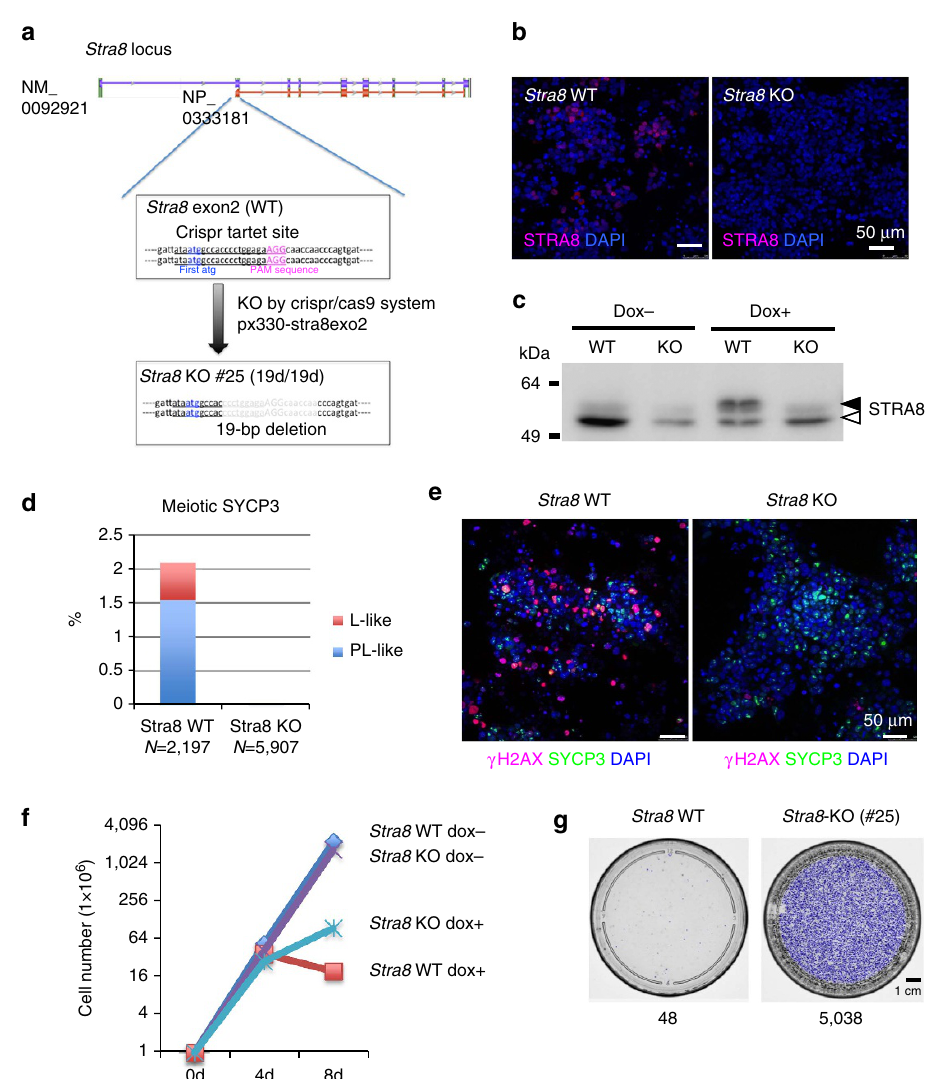
Figure 4 | Induction of the Max expression ablation-mediated meiosis-like SYCP3-staining pattern in ESCs depends on the presence of a functional Stra8 gene. ( a ) Schematic representation of CRISPR-Cas9-mediated disruption of the Stra8 gene. Genomic analyses revealed that Stra8 KO #25 clone had an out-of-frame mutation in both loci of the Stra8 gene due to homozygous deletion of 19 base pairs located immediately downstream of the ATG initiation codon in exon 2 of the gene. ( b ) Confirmation of the absence of functional Stra8 genes in the Stra8 KO #25 Max -null ESC clone. The Stra8 KO #25 clone and parental Max -null ESCs were treated with Dox for 9 days and then subjected to immunocytochemical analyses with an antibody against STRA8. ( c ) Western blot analyses of STRA8 in Stra8 KO #25 clone and parental Max -null ESCs cultured in the presence or absence of Dox. Solid and open arrowheads indicate specific and non-specific bands, respectively. ( d ) Frequency of preleptotene-, leptotene- and zygotene-like staining patterns in the Stra8 KO #25 clone and parental Max -null ESCs treated with Dox for 9 days. ( e ) Immunostaining analyses of g H2AX and SYCP3 in the Dox-treated (9 days) Stra8 KO #25 clone and parental Max -null ESCs. ( f ) Increase in the recovery of viable Dox-treated Max -null ESCs due to homozygous knockout of the Stra8 gene. The number of cells at day 0 was arbitrarily set to one. ( g ) Max -null ESCs (1 (cid:2) 10 5 ) with or without functional Stra8 genes were individually transferred to 10-cm dishes and treated with Dox for 12 days. The cells were then subjected to Leishman’s staining. Numbers under the dishes are the number of stained cell colonies. d, day; KO, knockout; WT, wild